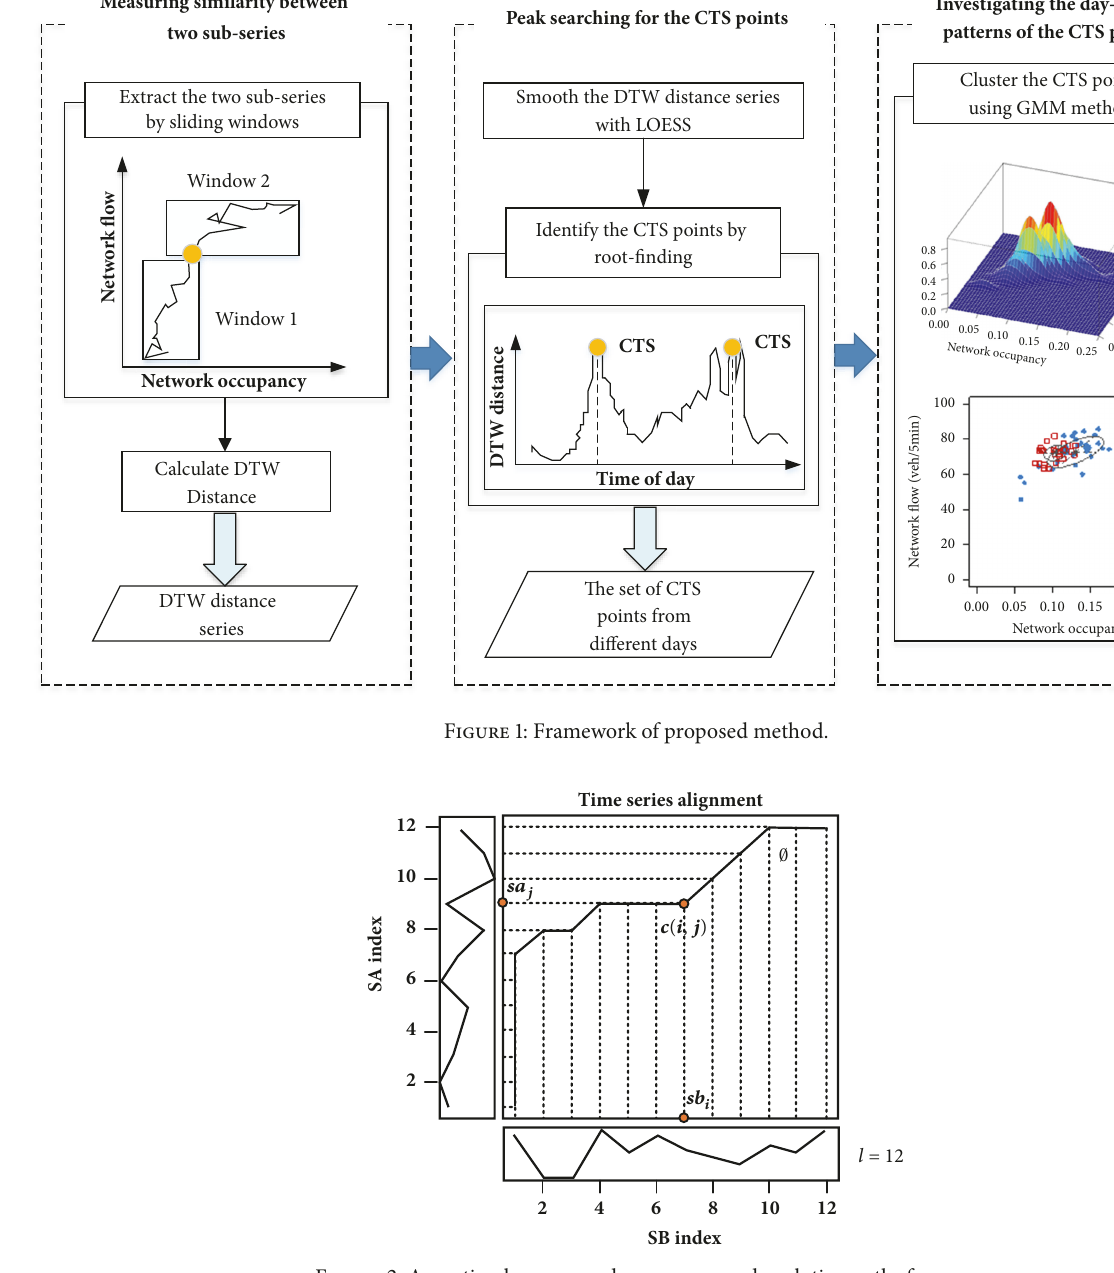
Figure 2: An optimal correspondence on warped evolution paths for 𝑠 𝑡